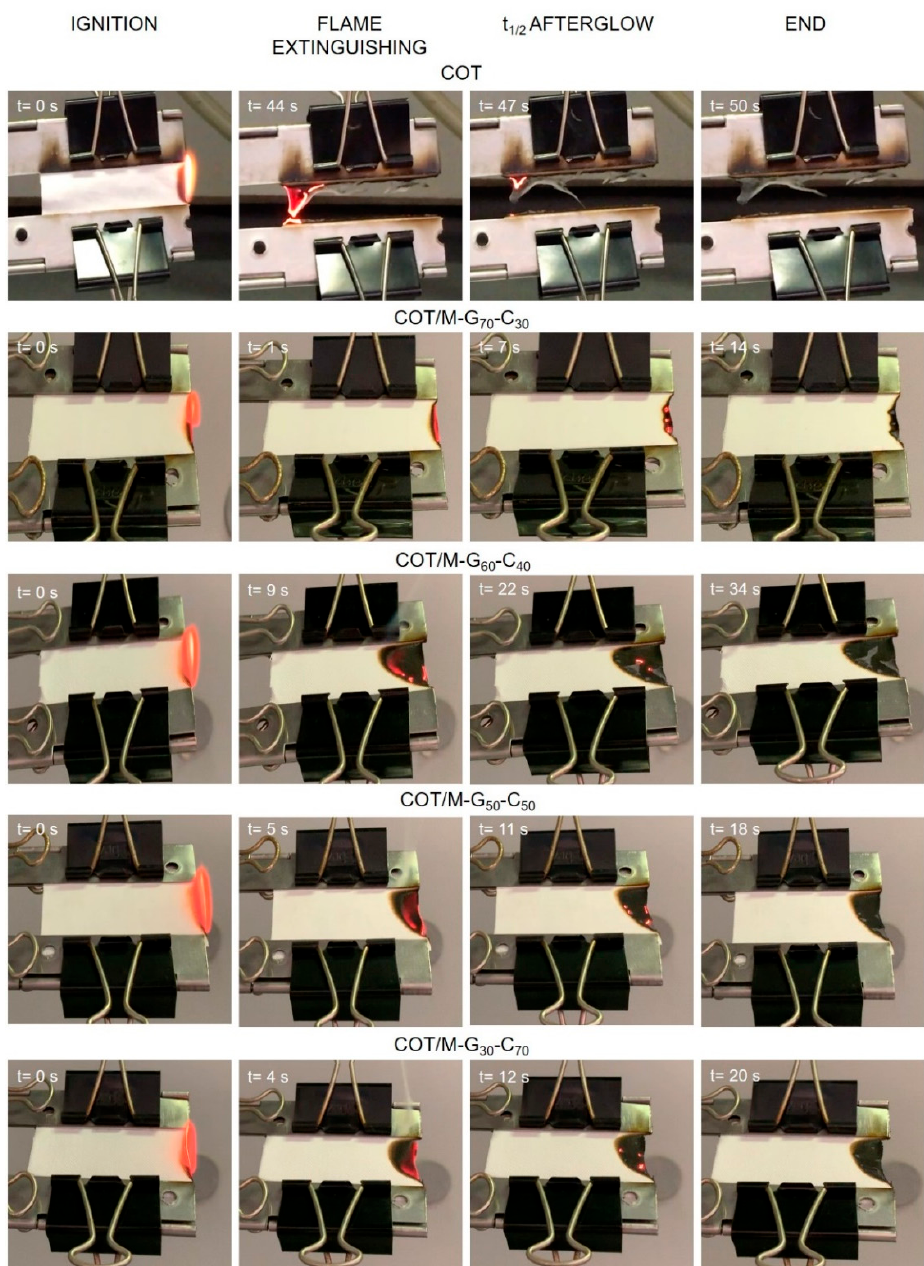
Figure 6. Snapshots of untreated, copolymeric PAA-treated cotton in horizontal flame spread tests. Add-ons: 16.4, 16.3, 16.0, and 16.2% for COT/M–G 70 –C 30 , COT/M–G 60 –C 40 , COT/M–G 50 –C 50 and COT/M–G 30 –C 70 , respectively.